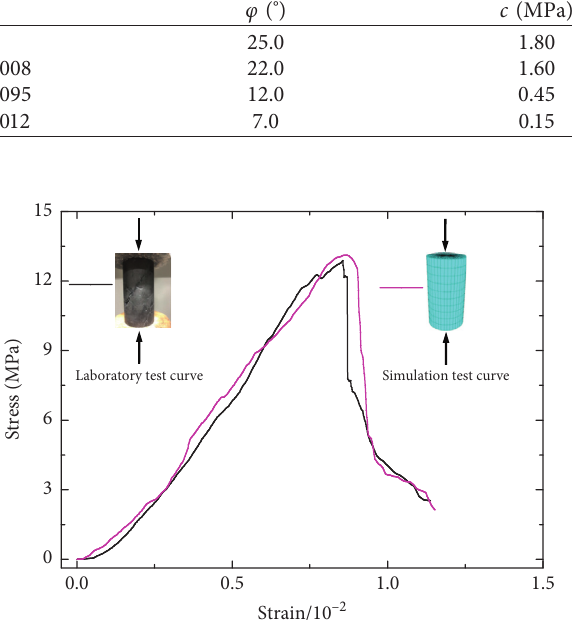
Figure 3: Stress-strain curves of laboratory test and